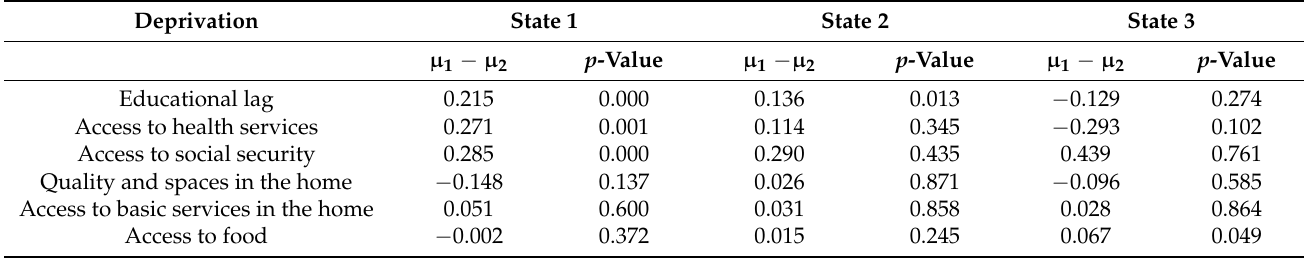
Table 8. Multivariate analysis of variance for diabetic and non-diabetic populations by states and social deprivation